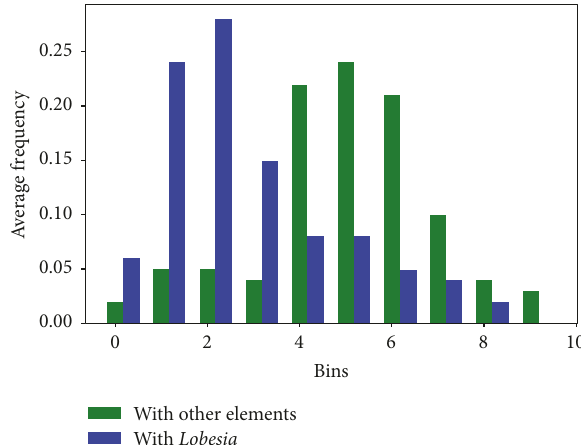
Figure10:Grayscaledescriptor Lobesia versusthatwithout Lobesia .